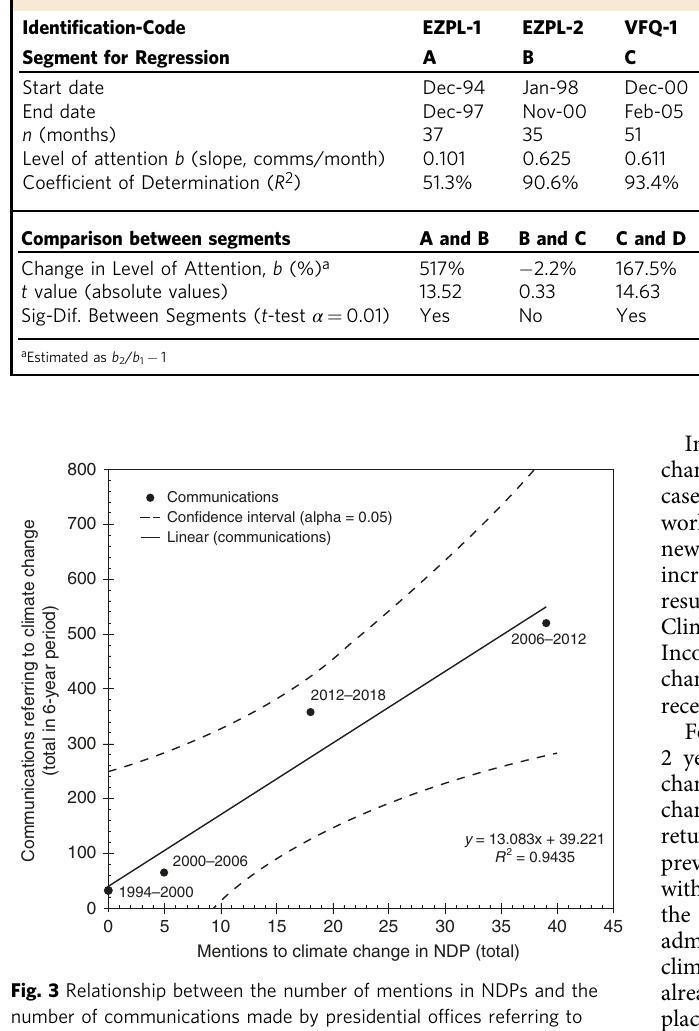
Table 2 Regression analysis in the level of attention of Mexican presidents to climate change after changes in governmental and systemic agendas (1994 – 2018).